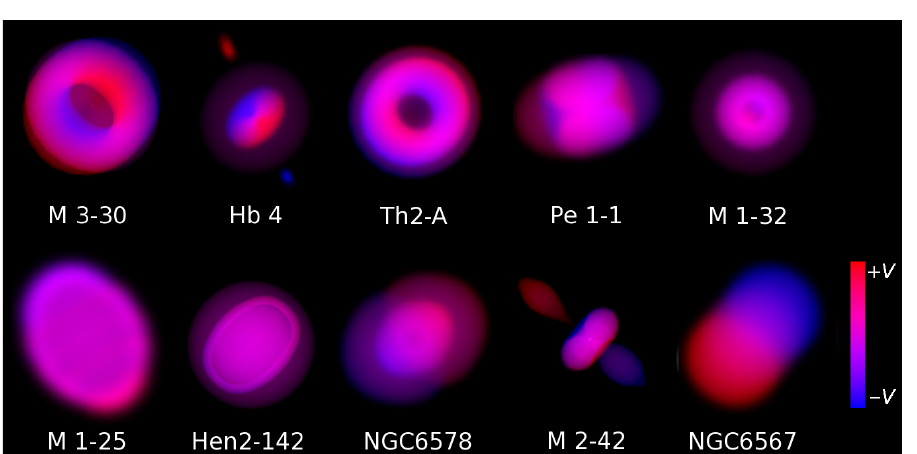
Figure 4. Wireframe SHAPE models ( top panel ) and their Doppler shift outputs ( bottom panel ) of M3-30, Hb4, Pe1-1, M1-32, M1-25, Hen2-142, MGC6578, and NGC6567 from Danehkar [29], along with Th2-A [26], and M2-42 [28]. Red and blue colors in the Doppler shift outputs are associated with redshift ( + V ) and blueshift ( − V ) effects relative to the centers, respectively. 3D interactive SHAPE models are provided by Danehkar [29], hosted on Sketchfab (https://skfb.ly/opFZv, 29 January 2022), and stored in a Zenodo data repository